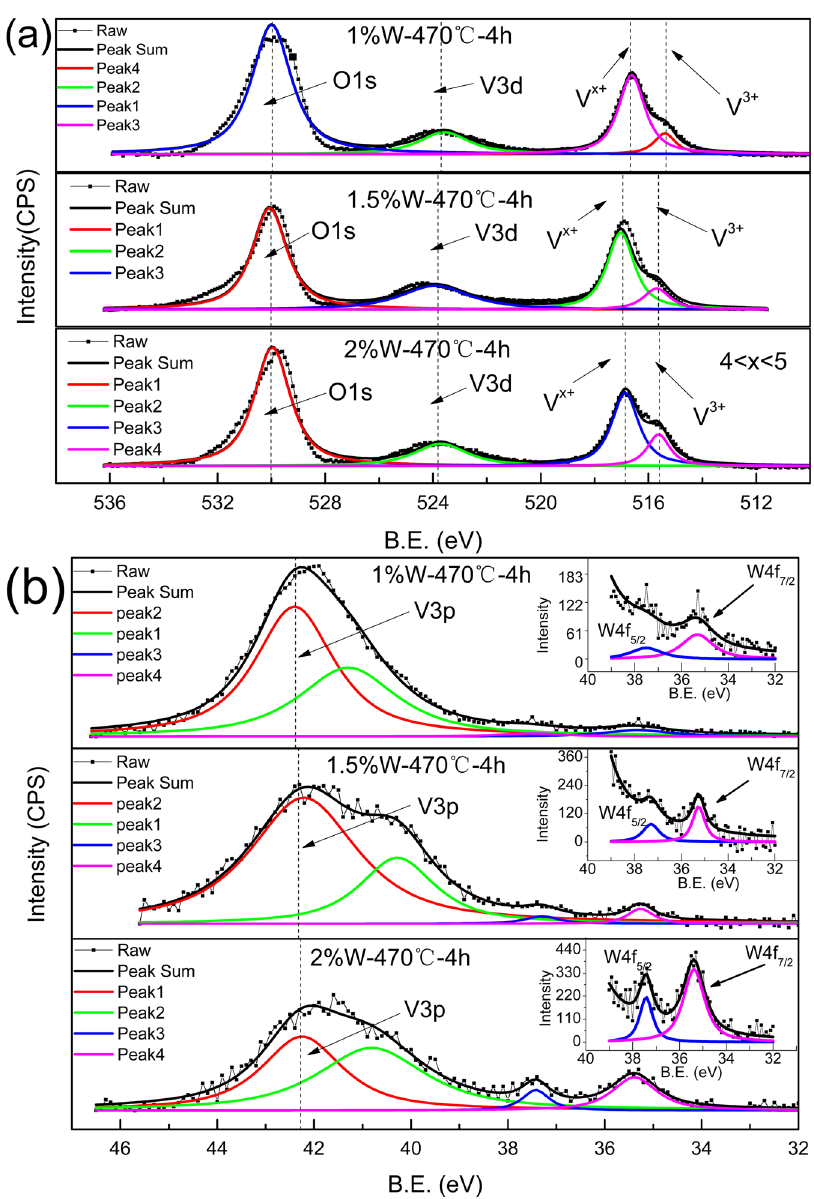
Figure 4. XPS survey spectrum of nominal 1 at.%, 1.5 at.% and nominal 2 at.%W -doped VO 2 annealed at 470 °C: ( a ) V2p3; ( b ) W4f. The dashed lines are guide for the